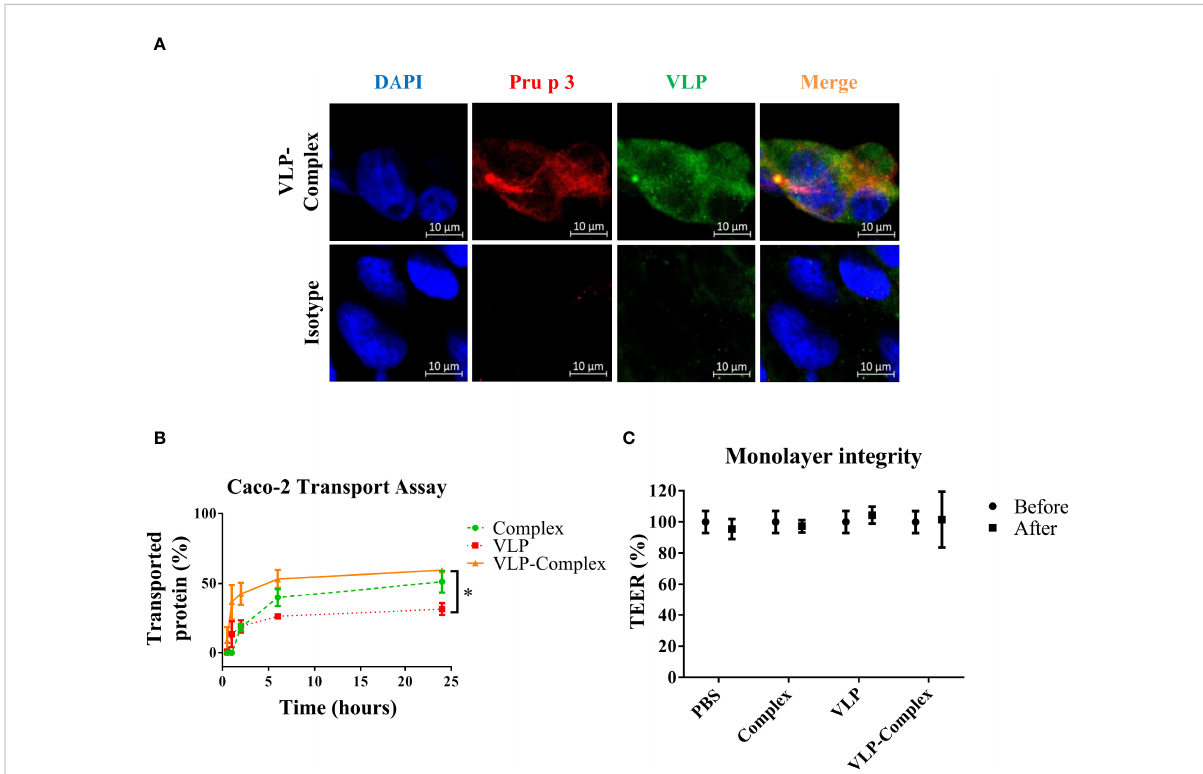
FIGURE 4 In vitro effects of VLP-Complex on epithelial cells. (A) Detection of VLP-Complex inside Caco-2 cells by immuno fl uorescence. Blue: DAPI, red: Pru p 3, green: VLP. Bar = 10 µm. (B) Detection by ELISA of VLP and VLP-Complex transported through a monolater of Caco-2 cells (in Transwell ™ format), using anti-VLP antibodies. *P < 0.05. (C) Monolayer integrity assessment by TEER measurement. All assays were performed in four technical replicates. Data are presented as mean (SD, Mann-Whitney